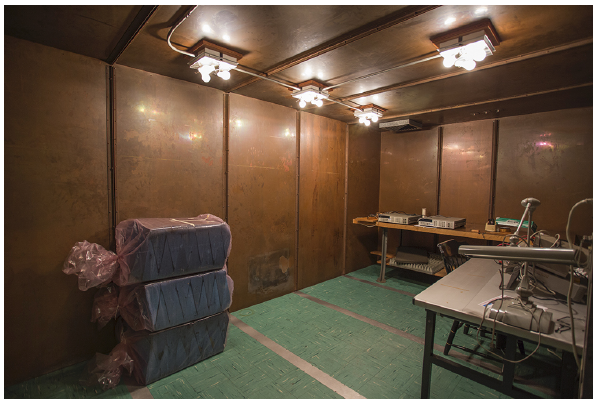
Figure 3. Zero-Gauss chamber at the Climate and Space Research